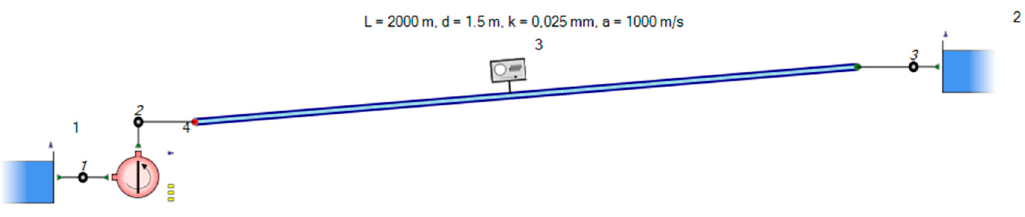
Figure 13. Numerical model for the system analysis.